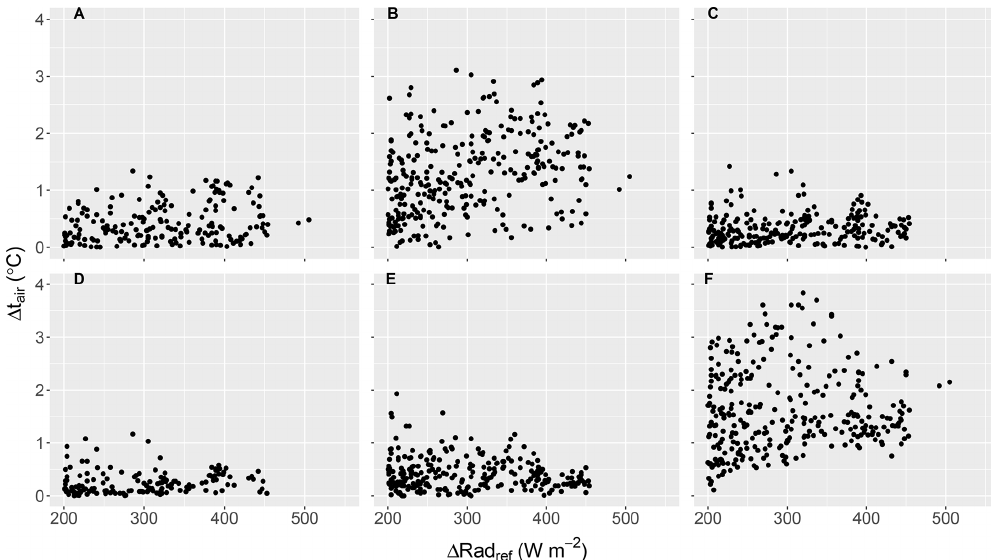
Figure 13. Temperature differences (cid:49)t air plotted as a function of reflected radiation differences between points a and b . Labels from A to F identify the instrument